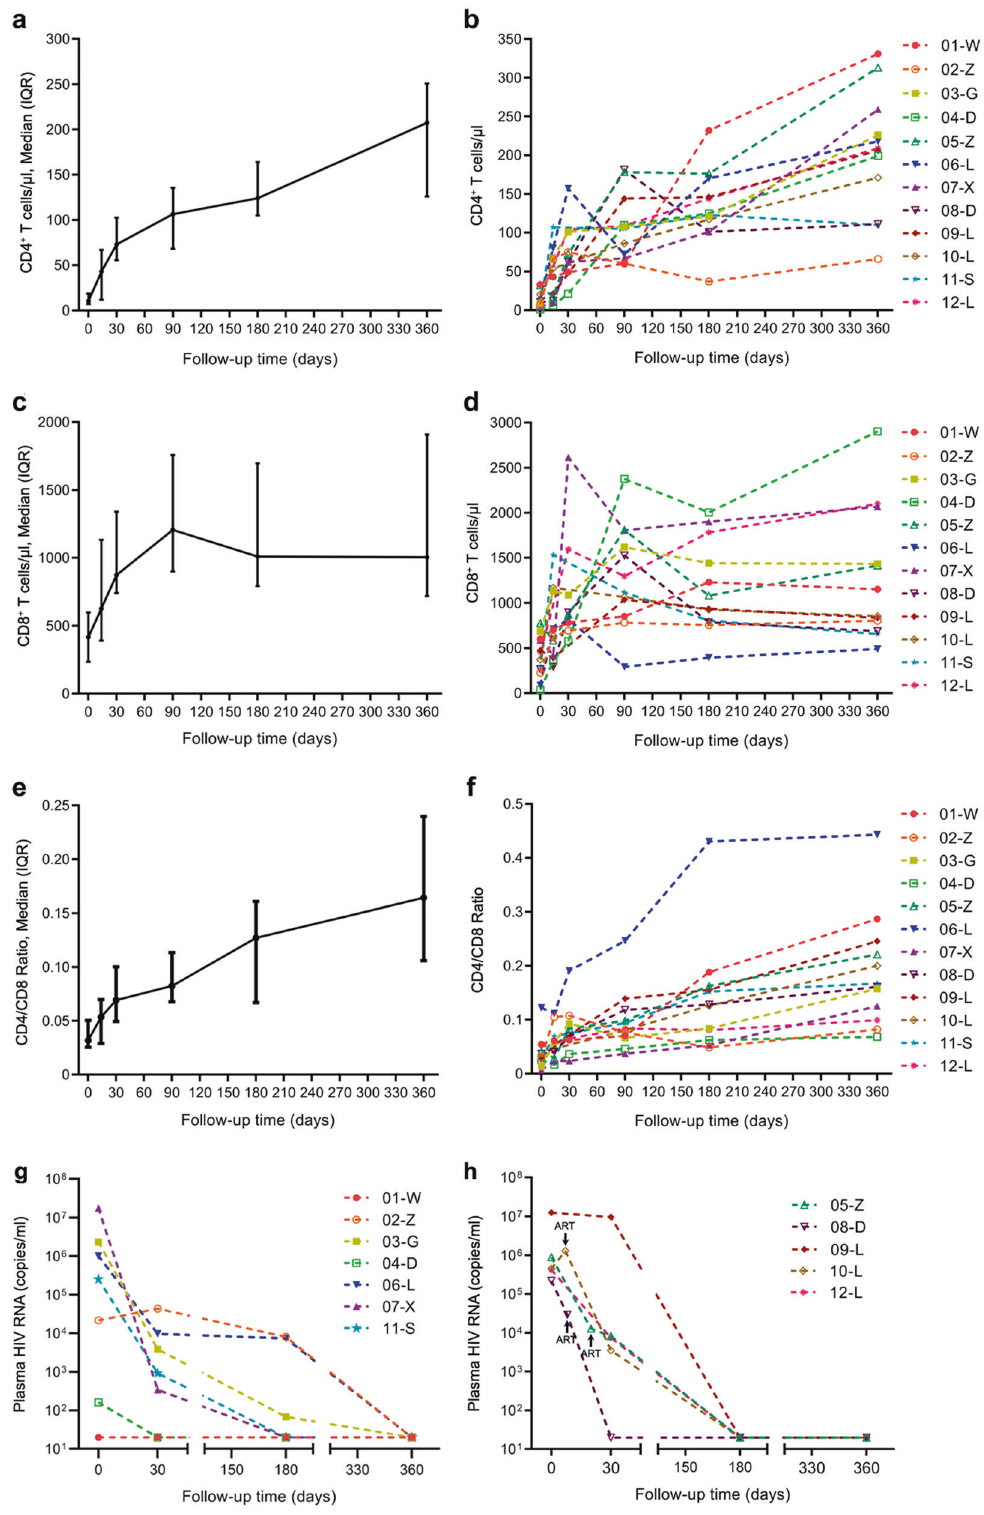
Fig. 2 Effects of AAIT on peripheral blood CD4 + /CD8 + T-cell counts and HIV RNA in severely immunosuppressed AIDS patients. a The trend of CD4 + T-cell counts in severely immunosuppressed AIDS patients. b Changes in CD4 + T-cell counts in each of the 12 severely immunosuppressed AIDS patients. c The trend of CD8 + T-cell counts in severely immunosuppressed AIDS patients. d Changes in CD8 + T-cell counts in each of the 12 severely immunosuppressed AIDS patients. e The trend of CD4/CD8 ratio in severely immunosuppressed AIDS patients. f Changes in CD4/CD8 ratio in each of the 12 severely immunosuppressed AIDS patients. g The change of HIV RNA in patients receiving ART before AAIT ( n = 7). h The change of HIV RNA in patients receiving AAIT before ART ( n = 5). For patient 05-Z, the AAIT was 20 days before ART. For patient 08-D, the AAIT was 8 days before ART. For patient 10-L, the AAIT was 7 days before ART. For the other two patients, the AAIT was 2 days before ART. The arrows represent the time of ART start Signal Transduction and Targeted Therapy (2021)